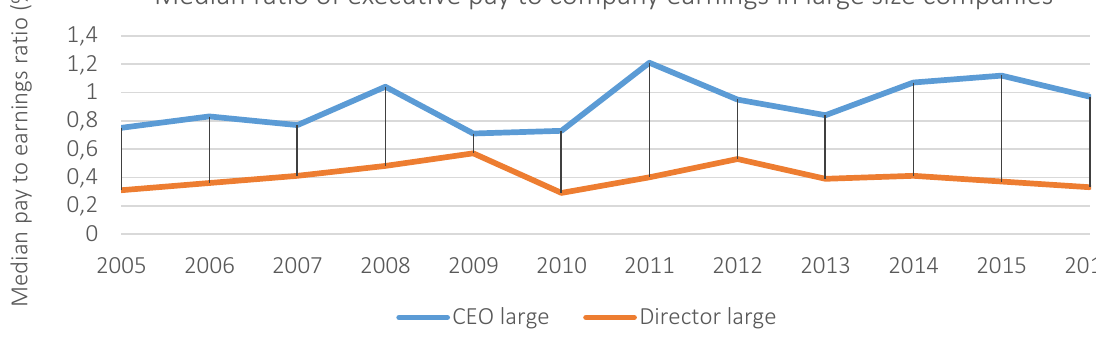
Figure 3. Pay to earnings ratio in large companies